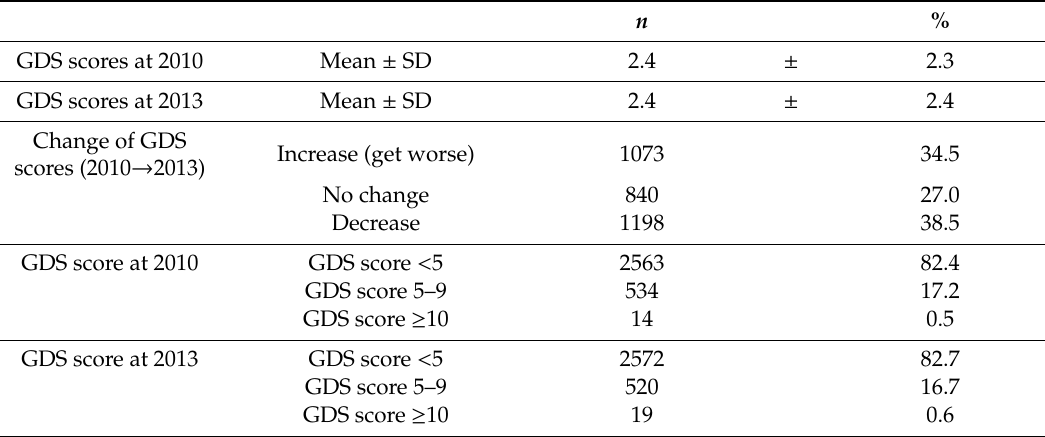
Table 1. Socio-demographic characteristics ( n =